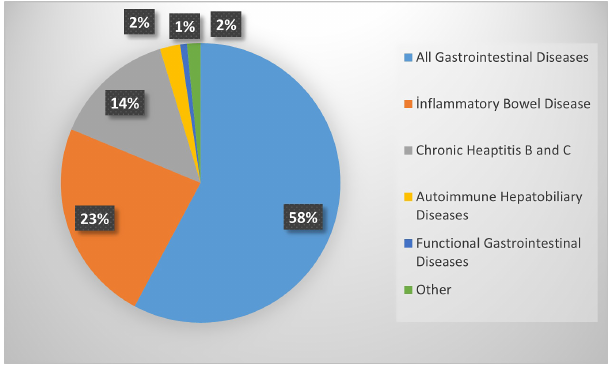
Figure 2. Chronic diseases, the management of which is considered to be the most